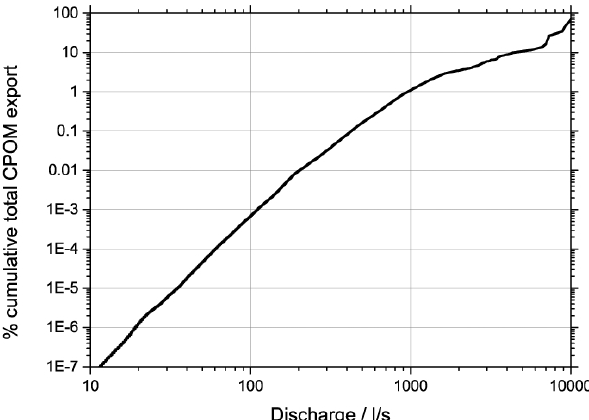
Figure 9. Percentage of the total cumulative CPOM export from the catchment as a function of discharge, obtained by integrating the rating curves with the 10min discharge data 1983–2012. Only about 10% of the total export is delivered by discharges lower than ∼ 4000Ls − 1 , which is on average exceeded for less than 6minyr − 1 . Thus, large events dominate the